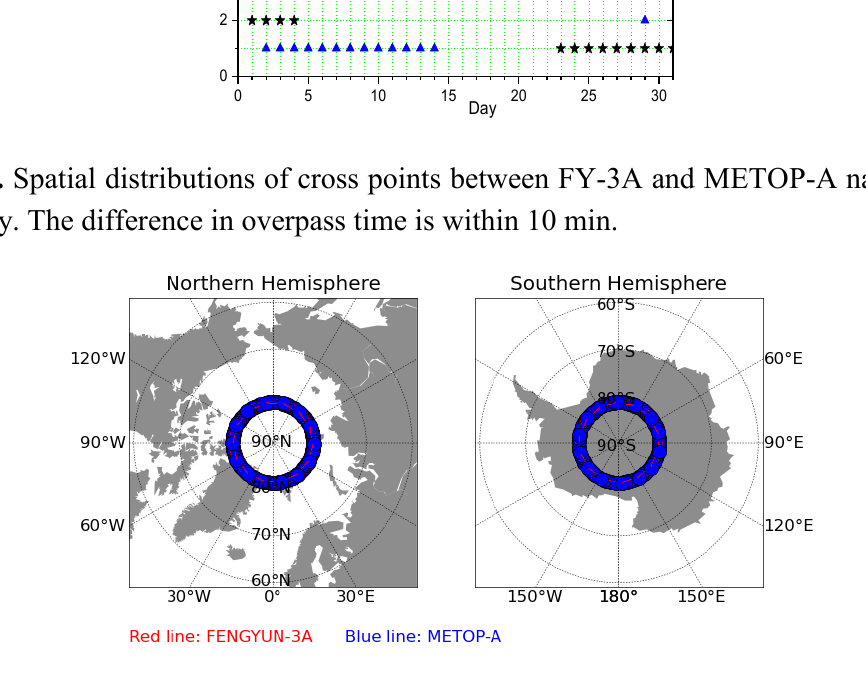
Figure 4. Spatial distributions of cross points between FY-3B and METOP-A nadir tracks in one day. The difference in overpass time is within 10